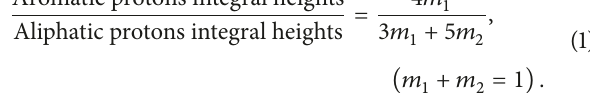
1.400 g (0.014 mol) MMA, and 0.014 g AIBN) in which 1,4- dioxane was used as solvent and AIBN was used as initiator. Each mixture was passed from argon gas flows for 10